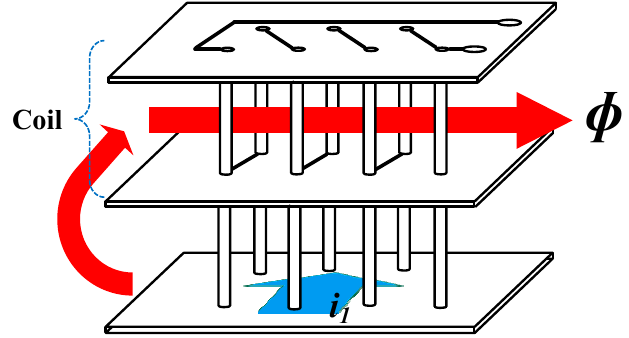
Figure 2. Conventional printed circuit board (PCB) pick-up coil design.